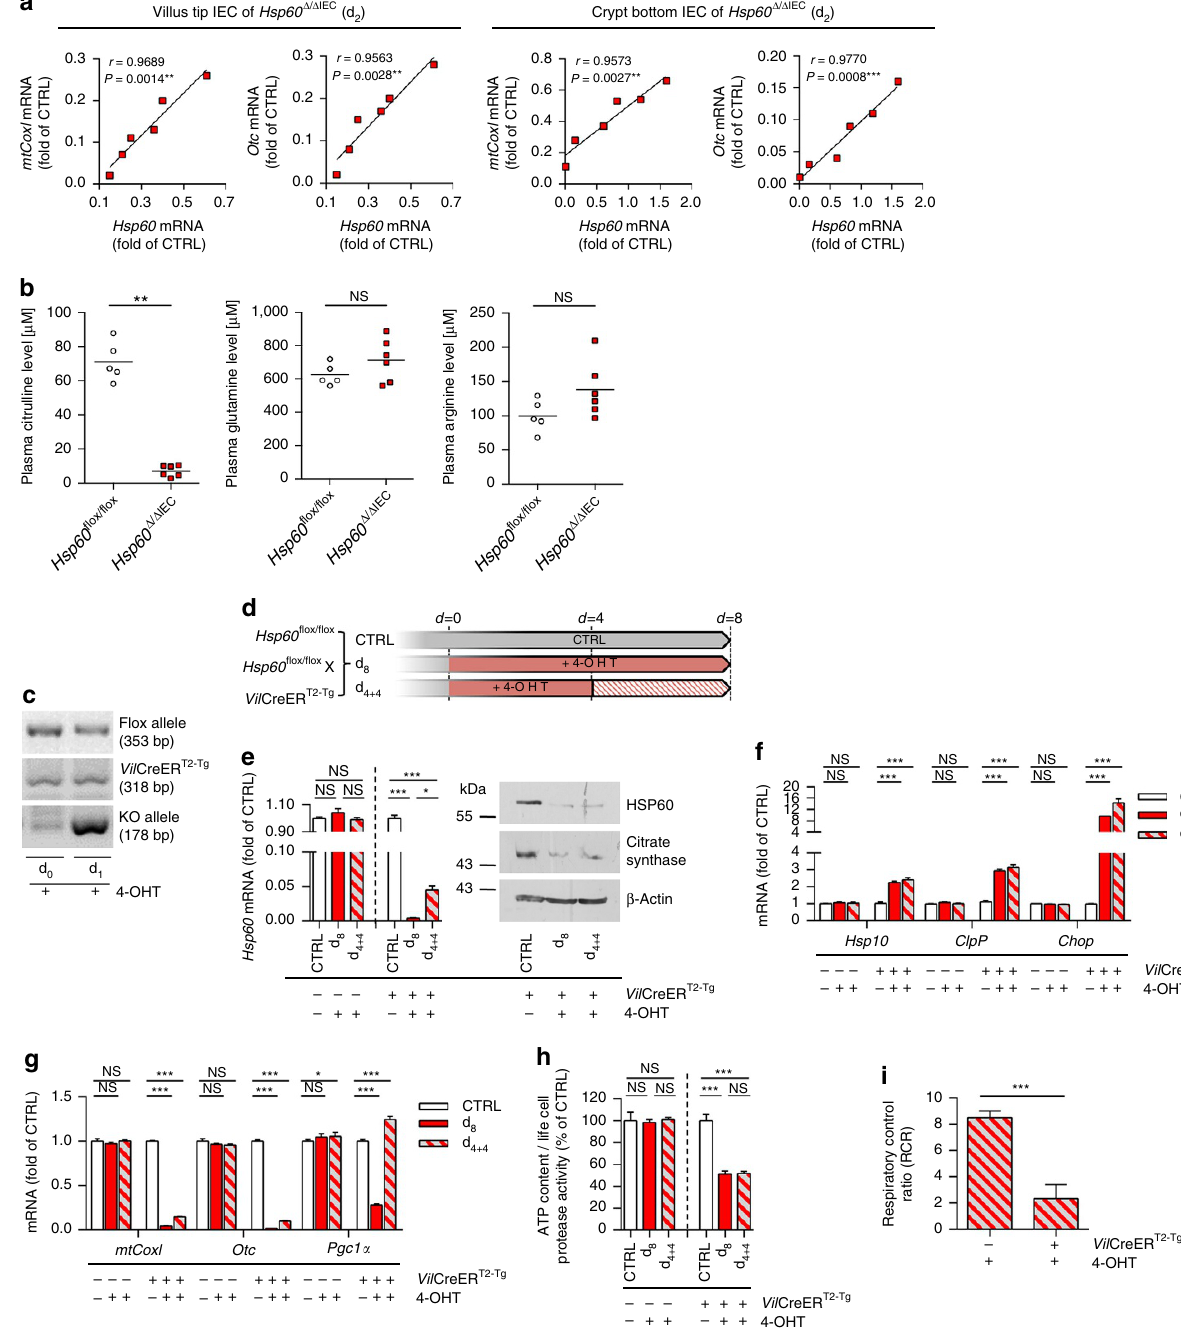
Figure 4 | HSP60 deficiency impairs mitochondrial function. ( a ) Correlation (Pearson) of expression levels of mtCoxI and Otc , involved in mitochondrial function, with Hsp60 mRNA levels in isolated IEC from villus (left) and crypt (right) compartment of Hsp60 D / D IEC mice ( N ¼ 6 per genotype). P values indicate one-sided significance. ( b ) Plasma citrulline (left), glutamine (middle) and arginine (right) level in Hsp60 D / D IEC mice at d 2 ( N ¼ 6) and Hsp60 flox/flox controls ( N ¼ 5). Statistical analysis was performed using unpaired t -tests. ( c ) Agarose gel showing the presence of the Hsp60 -knockout allele in genomic DNA isolated from organoids at 1 day after tamoxifen (4-OHT) addition. ( d ) Schematic illustration of the experimental set-up using small intestinal organoids ex vivo . Organoids were isolated from Hsp60 flox/flox , Villin CreER T2-Tg and according Villin CreER T2 negative control mice and distributed to three protocols. One-way analysis of variance and appropriate post hoc test were used for statistical analysis. ( e ) mRNA (left) and protein (right) expression levels of Hsp60 in organoids after 4-OHT treatment. Protein levels of mitochondria-located citrate synthase and b -Actin serving as loading control are also shown. ( f ) qRT–PCR analysis of target genes involved in MT-UPR. ( g ) qRT–PCR analysis of target genes involved in mitochondrial function. ( h ) ATP content of organoids relative to life cell protease activity measured by a fluorescence assay. ( i ) Respiratory capacity of mitochondria was measured by high-resolution respirometry. To exclude toxicity-related artefacts of 4-OHT, effects on CreER T2-Tg organoids were directly compared to CreER T2 - negative organoids both receiving 4-OHT. Statistics were performed by unpaired t -test. Data from organoid experiments derive from at least 3 independent experiments. Bars represent mean þ s.e.m. Asterisks indicate significant differences * P o 0.05, ** P o 0.01, *** P o 0.001; NS, not significant.